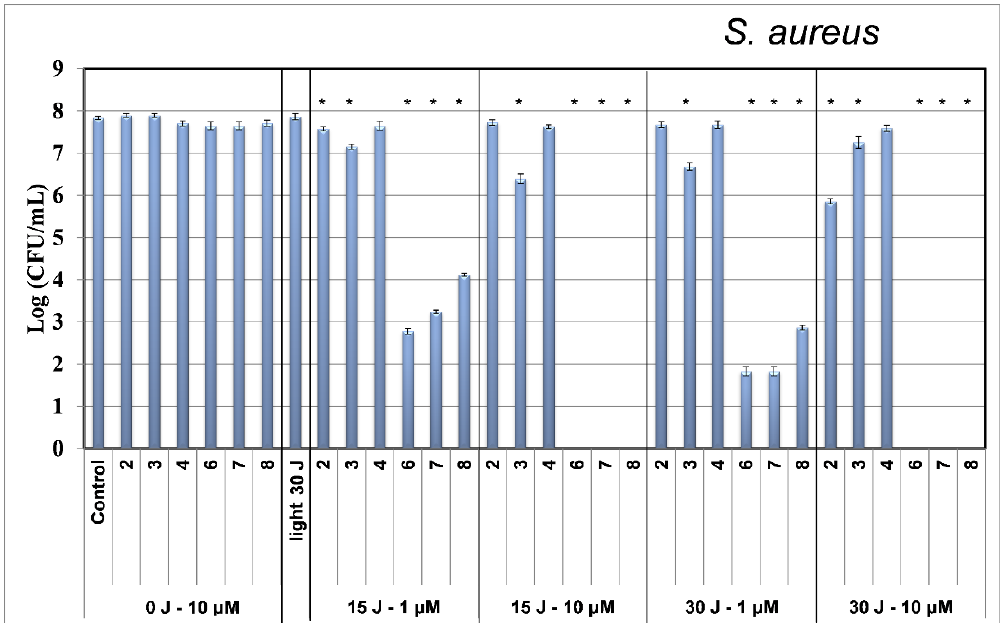
Figure 3. Staphyloccocus aureus counts (log CFU/mL) for 1 µM and 10 µM of photosensitizers 2 – 4 and 6 – 8 with the light doses of 0 Jcm − 2 (control), 15 Jcm − 2 and 30 Jcm − 2 . Results are presented as mean ± SE. All the experiments were statistically evaluated (Tukey’s test) and are in agreement with significance level of at least p < 0.05. Experiments pointed out with (*) represent p < 0.05 when compared to the control.